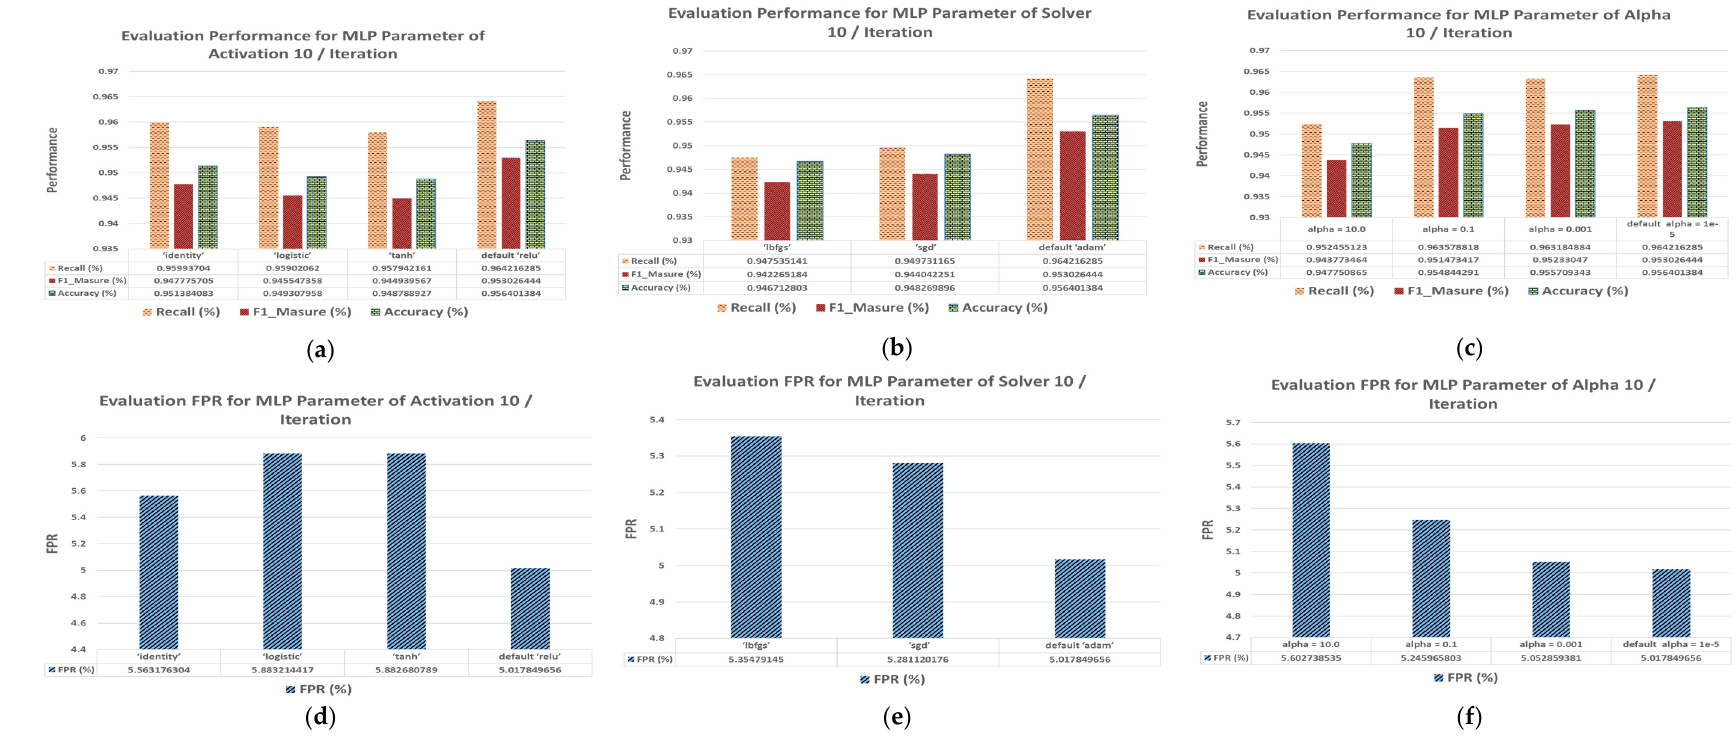
Figure 10. Performance of MLP parameters: ( a ) Evaluation Performance of Activation; ( b ) Evaluation Performance of Solver; ( c ) Evaluation Performance of Alpha; ( d ) Evaluation FPR for Activation; ( e ) Evaluation FPR of Solver; ( f ) Evaluation FPR of Alpha.